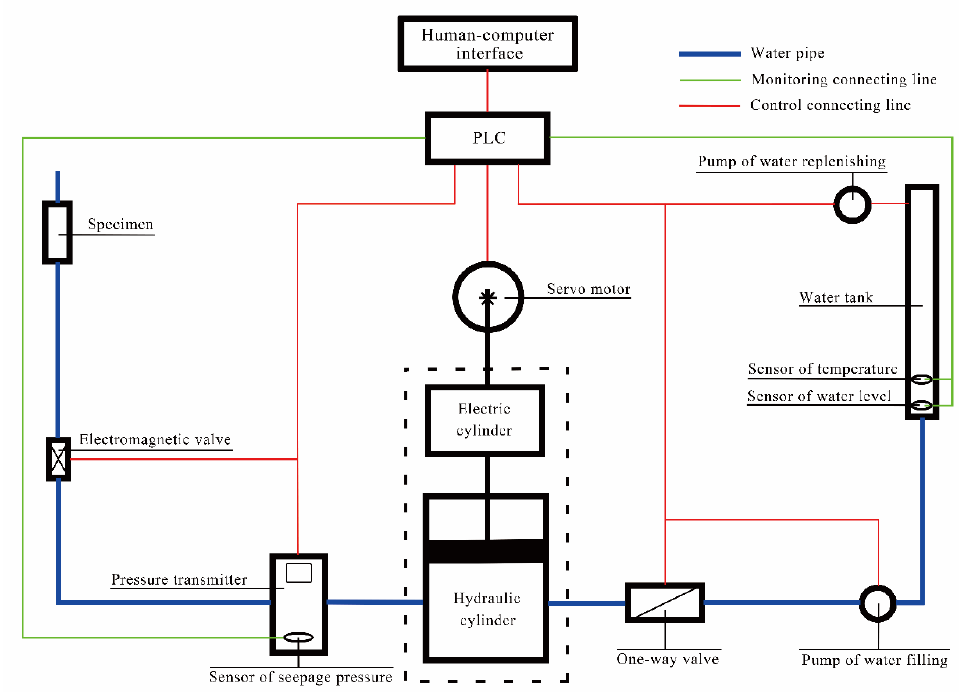
Figure 1. Schematic diagram of the seepage apparatus structure.